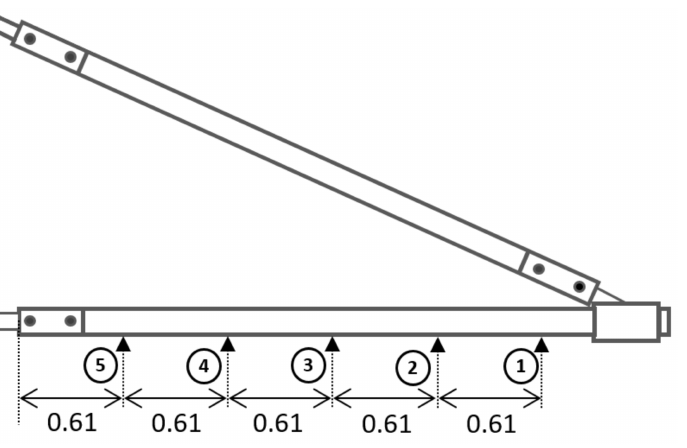
Figure 3. Positions of dial gauges under the cross-arm to measure creep strain pattern, in